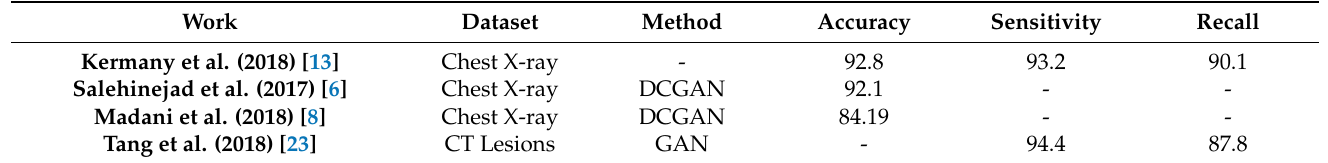
Table 3. Comparative measures on prior